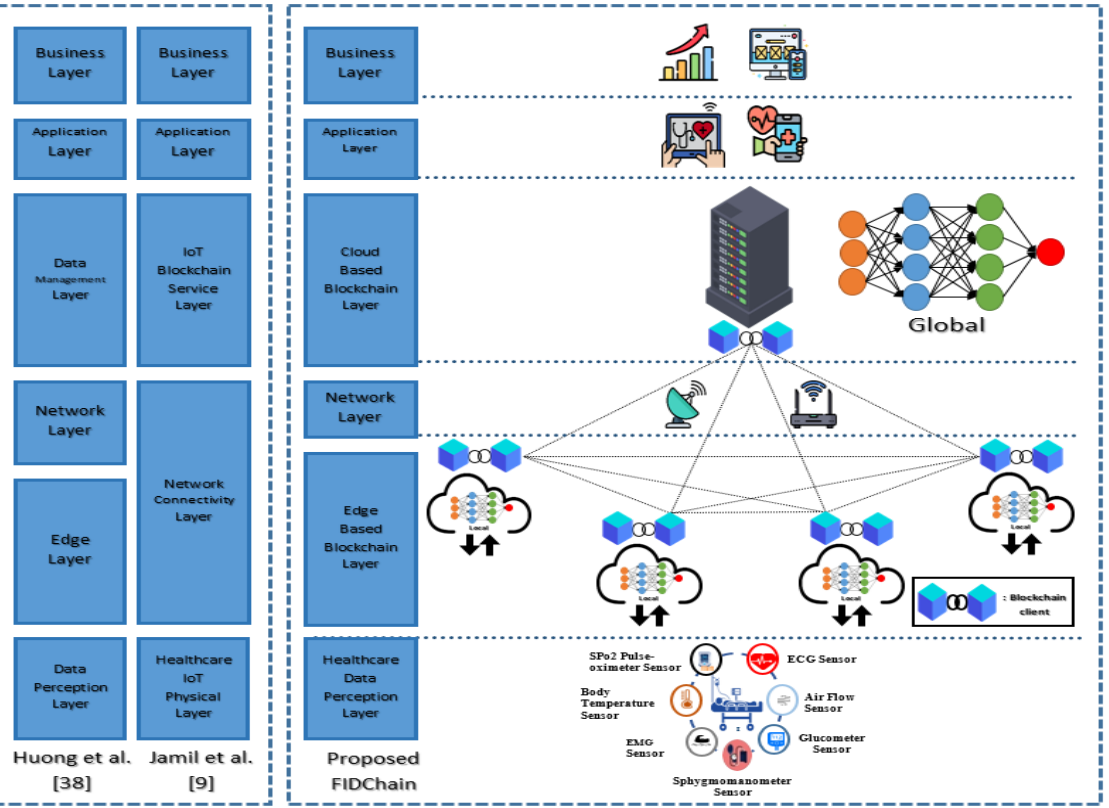
Figure 1. Layered architecture of the proposed system FIDChain.